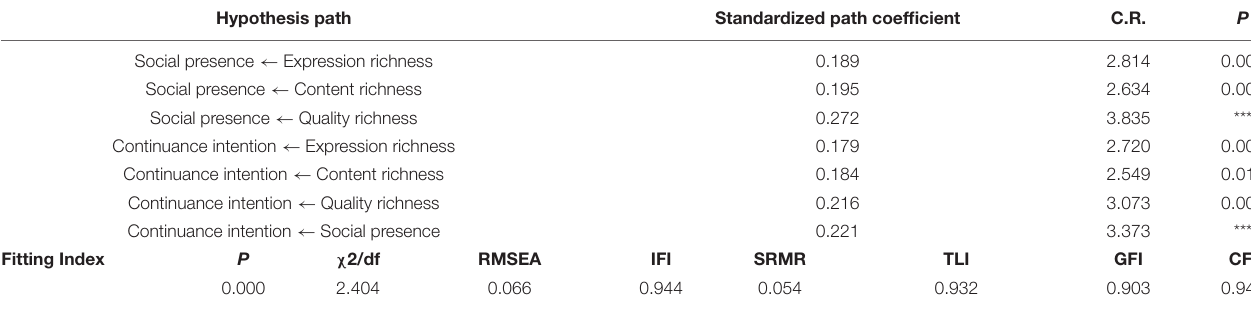
TABLE 4 | Analysis results of structural equation model.